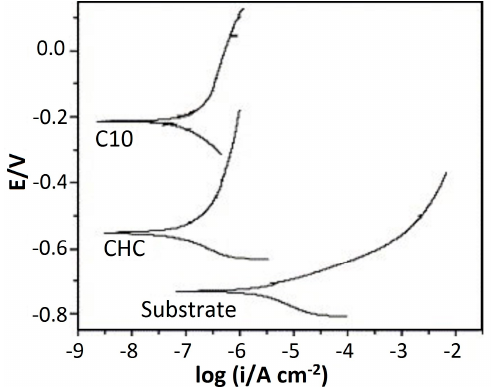
Figure 7. Potentiodynamic polarization curves for C10 (Cr 3 C 2 –NiCr-coated sample), CHC (hard chromium coating), and steel substrate after 20 h immersion in 3.4% NaCl at 25 °C [102] . Reprinted with permission from ref [102]. © 2006 Elsevier.